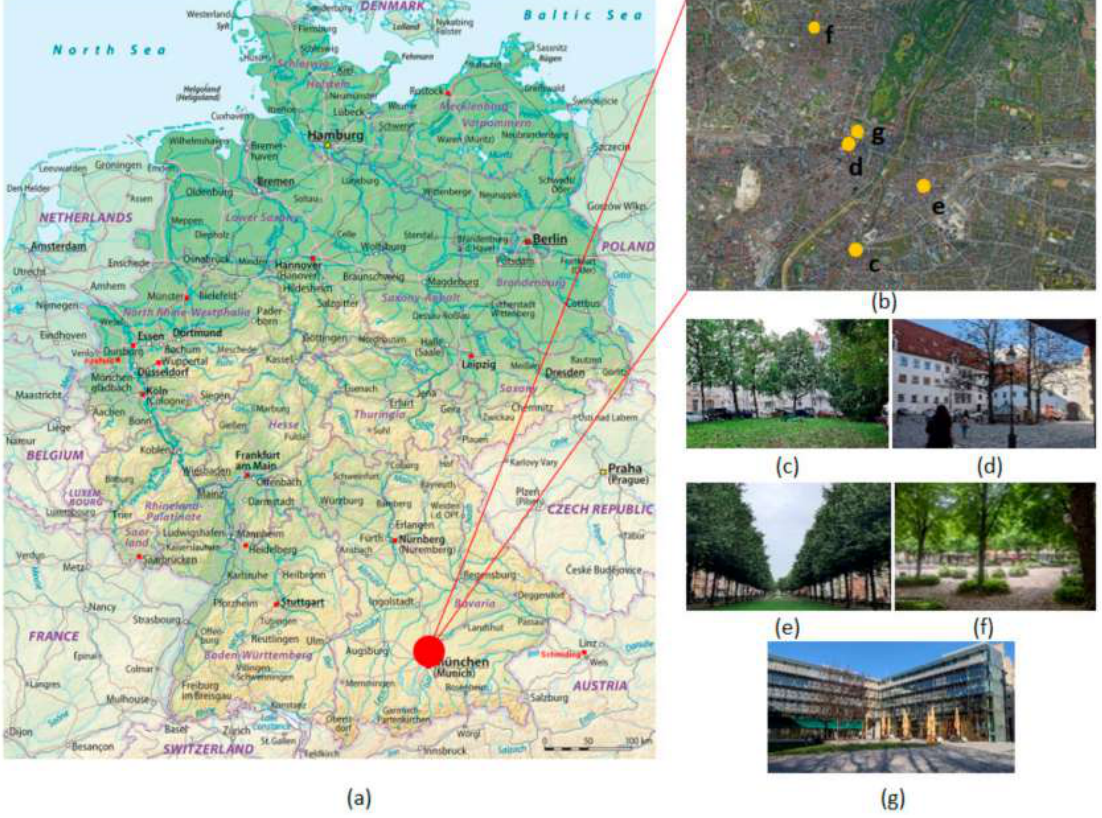
Figure 1. Location of Munich in Germany ( a ) and Munich’s selected squares ( b ); Alpenplatz ( c ); Alter Hof ( d ); Bordeauxplatz ( e ); Hohenzollernplatz ( f ); Marstallplatz ( g ). Source: Priscila W. Stark da Silva (with basic geographical data provided by www.google.com and www.flickr.com accessed on 5 February